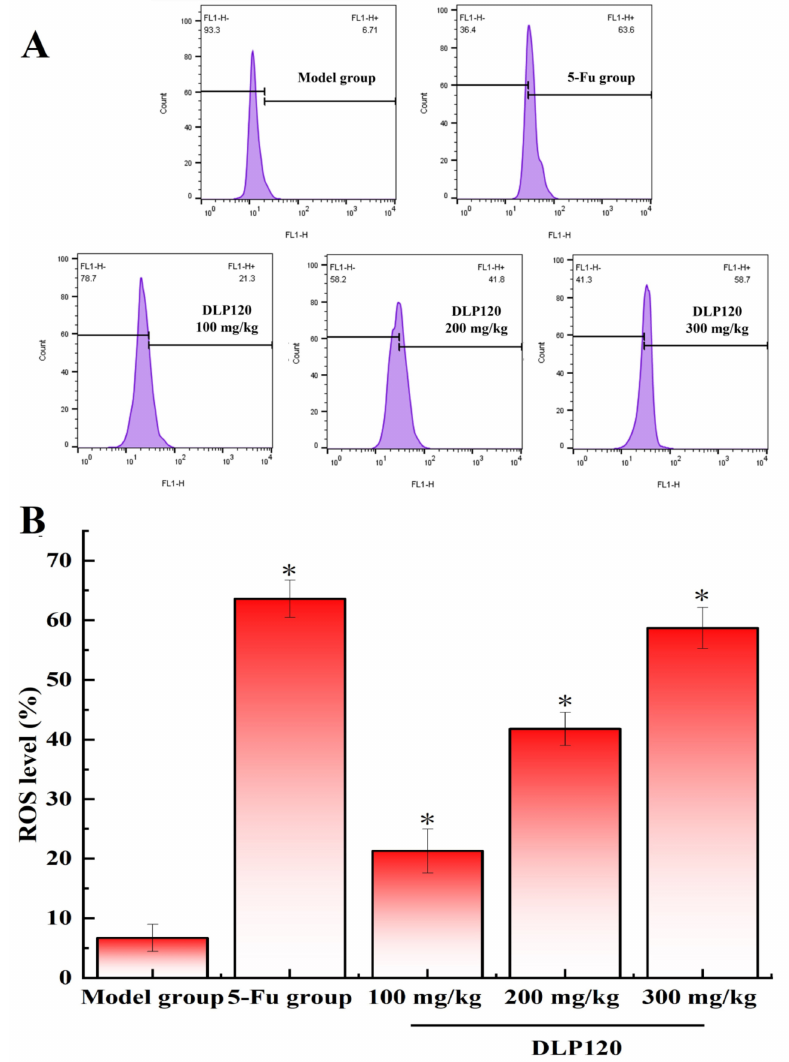
Figure 8. ROS levels ( A ) and a representative bar graph ( B ) of ROS levels in tumor cells. Note: * p < 0.05, compared to 5-Fu